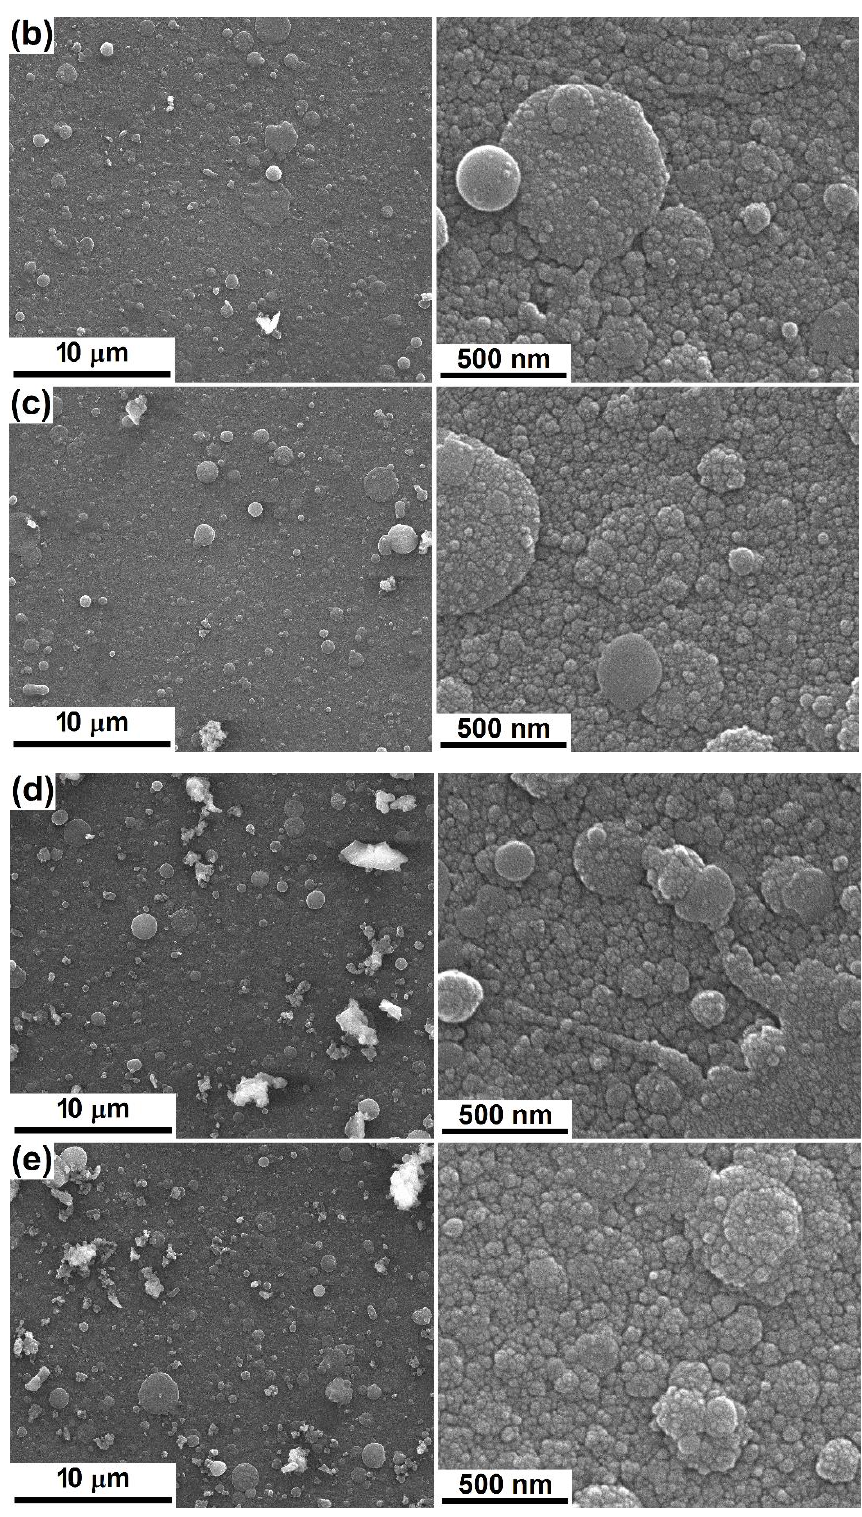
Figure 2. SEM images at different magnifications of: ( a ) bare substrate and ( b ) PLD-Mg-1, ( c ) PLD-Mg-2, ( d ) PLD-Sr-1 and ( e ) PCL-Sr-2 interfaces.